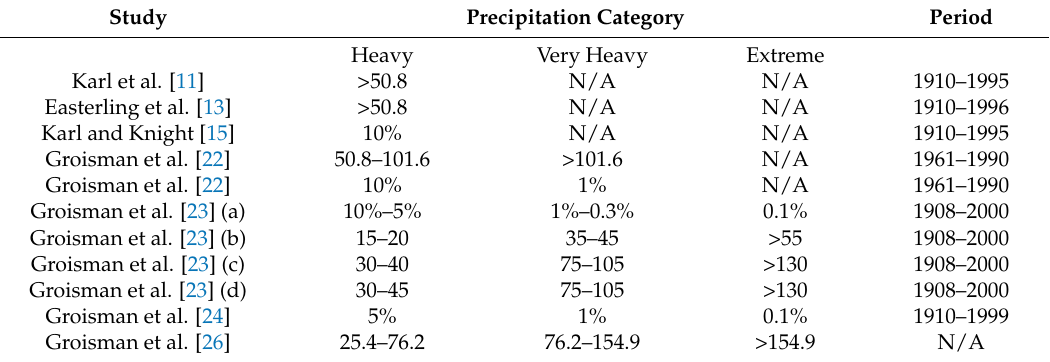
Table 1. Categories of intense precipitation reported by various studies (as mentioned) based on either fixed numerical [numerical values (with units “mm/day”)] or percentile-defined [values followed by percent sign (%)]